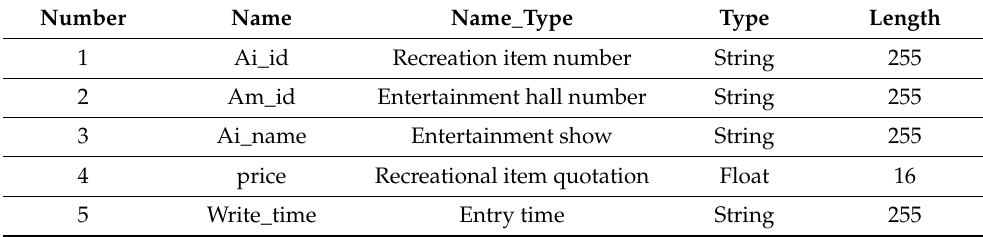
Table 1. Application of Smart Tourism System